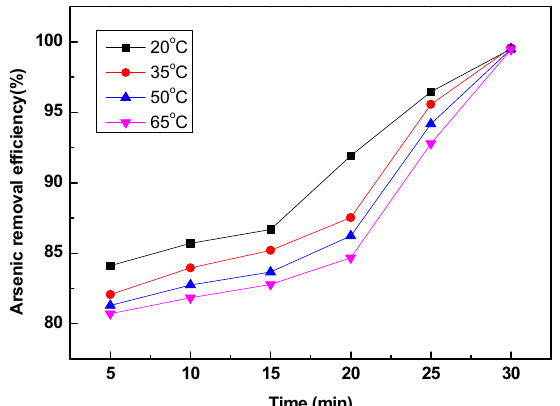
Figure 1. Effect of reaction temperature on arsenic removal efficiency (experimental conditions: molar ratio of iron to arsenic was 6, CuSO 4 concentration was 0.5 g/L, reaction time was 30 min, and stirring speed was 300 rpm).